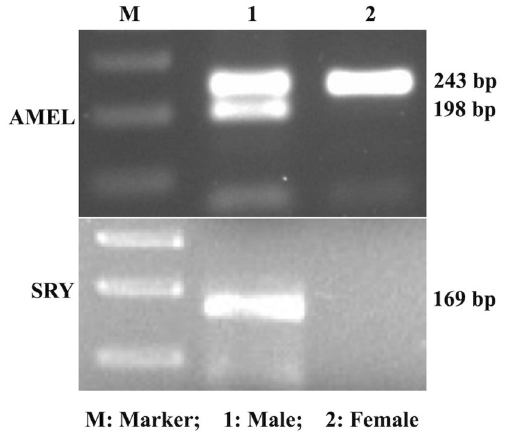
Figure 2. Expression of AMEL and SRY in genomic DNA of blood.